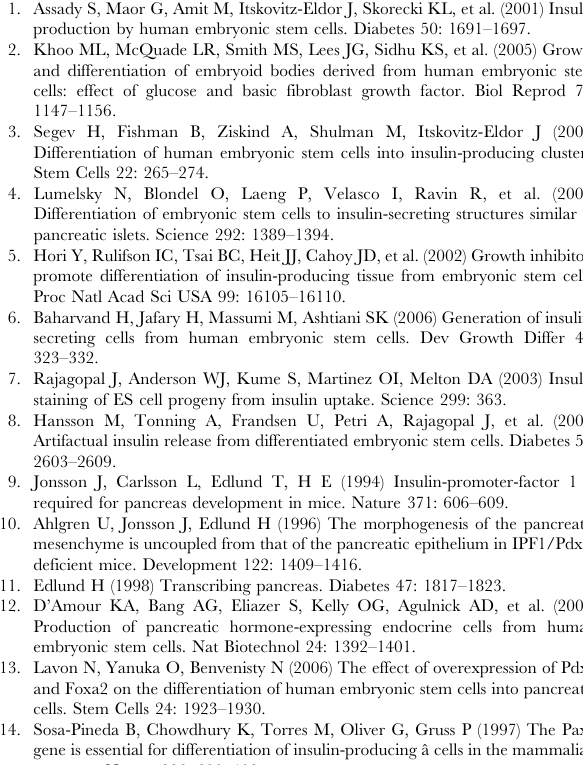
Figure S3 Somatostatin (SST) transcripts were detected in as early as 7-day differentiation in H7 EBs, however, there were increased levels of SST transcripts in H7.Px4 EBs. This is consistent with the observation that PAX4 commits the early endocrine cells to become somatostatin-producing delta-cells, as in the mouse pancreas (St-Onge et al., 1997). Figure S4 Spontaneous differentiation of H7.Px4 EBs also gave rise to cells characteristics of all three germ cell layers. RT-PCR analysis of gene expression in EBs produced from untransfected H7 cells and from two independent H7.Px4 clones after 16-21-day in vitro differentiation. Genes characteristic of other lineages such as endoderm (AFP), mesoderm (Coll2) and ectoderm (MAP2) continued to appear in H7.Px4 EBs but was similar to those in untransfected H7 EBs. M,